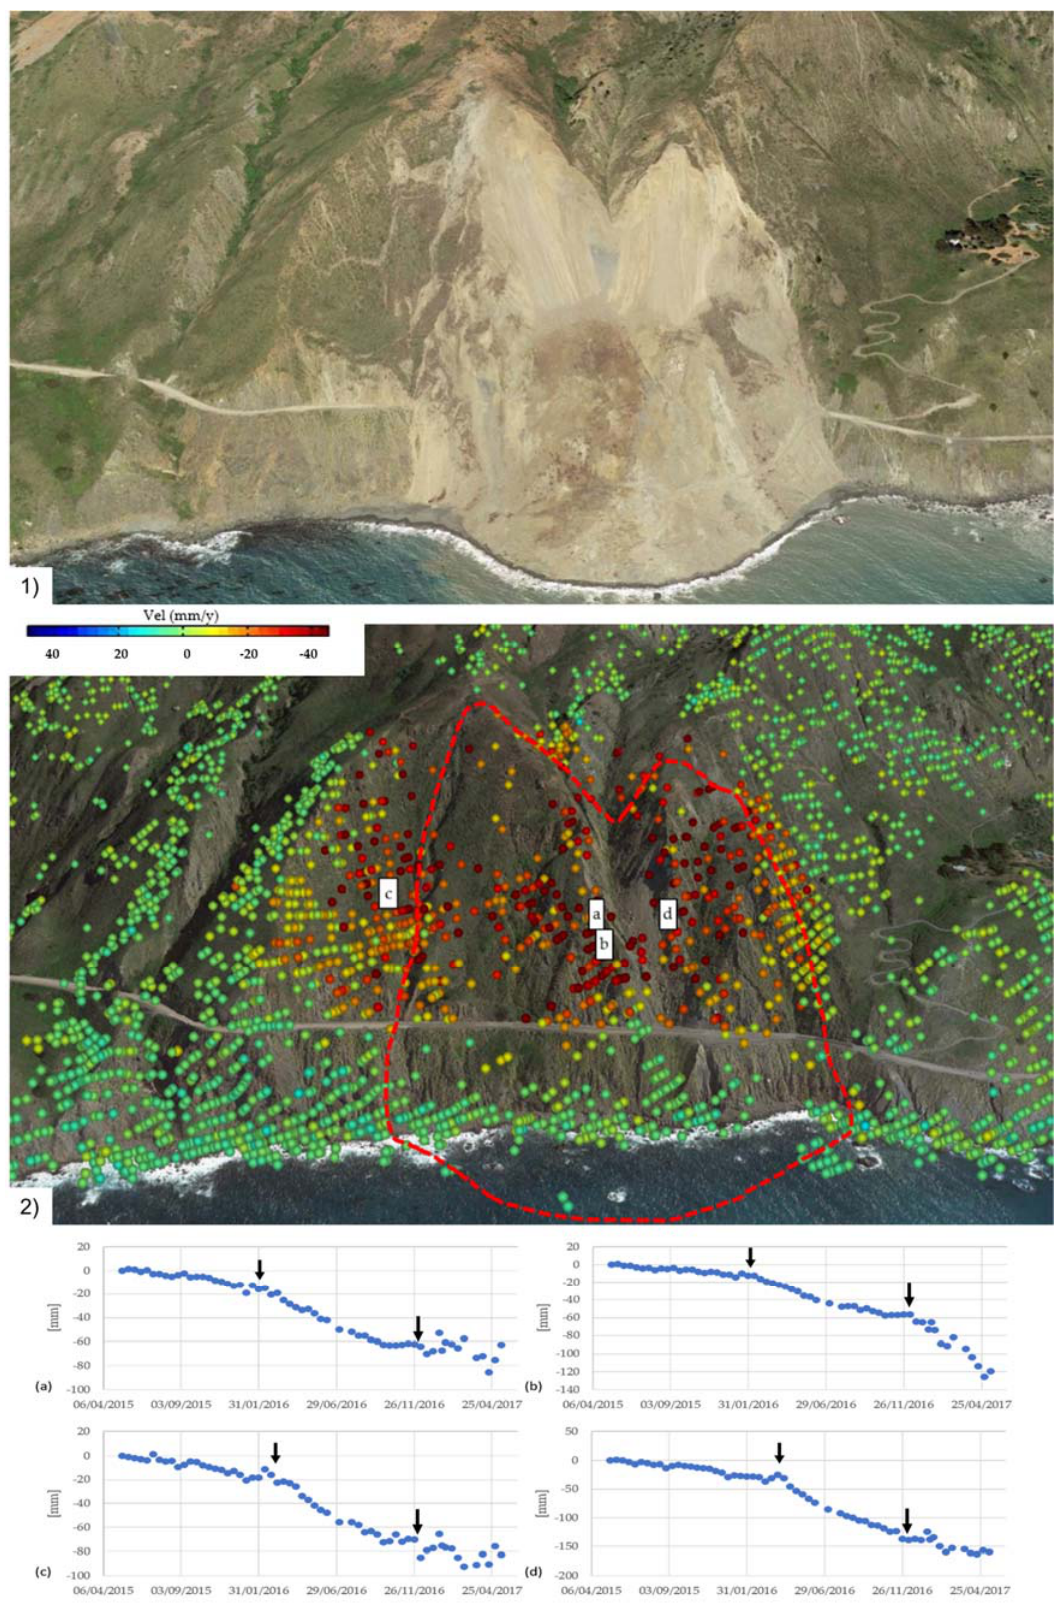
Figure 8. 1) Landslide view from Google Earth. 2) A ‐ DInSAR pre ‐ failure analysis for the Mud Creek landslide area includ ‐ ing the average velocity map and the time series of displacement for measurement points (a), (b), (c), (d). The landslide boundary is represented by the red dashed line. (Lat: 35.866303°; Lon: − 121.430347°; WGS84).